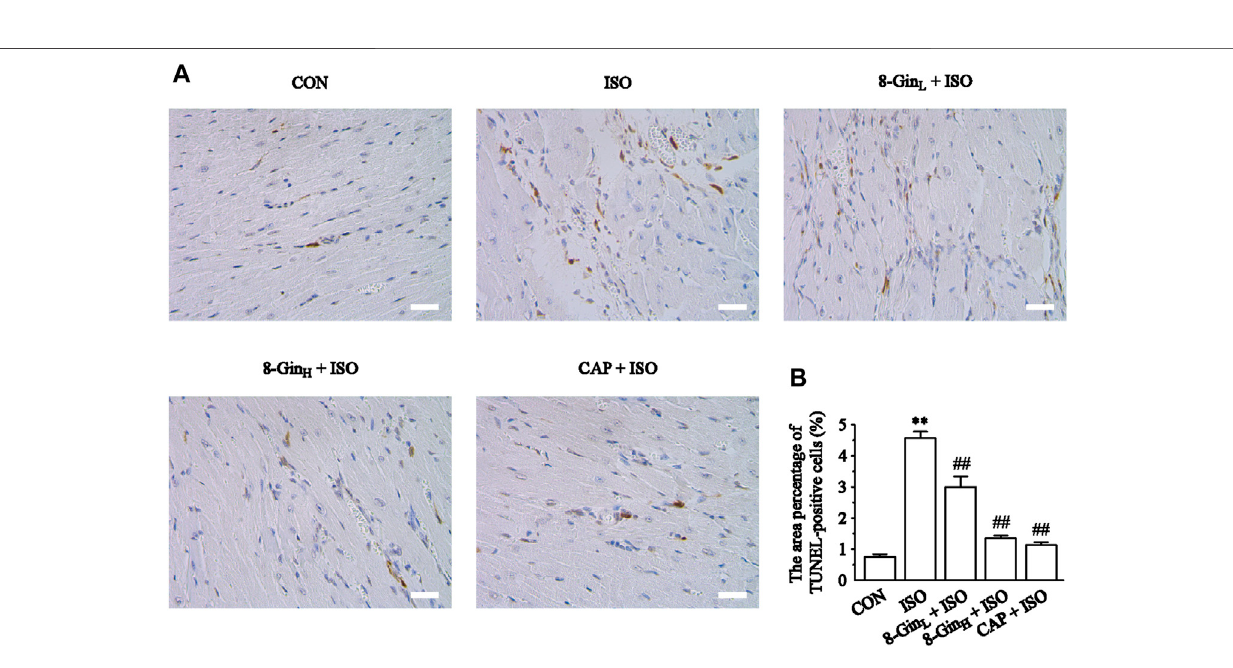
Frontiers in Pharmacology |